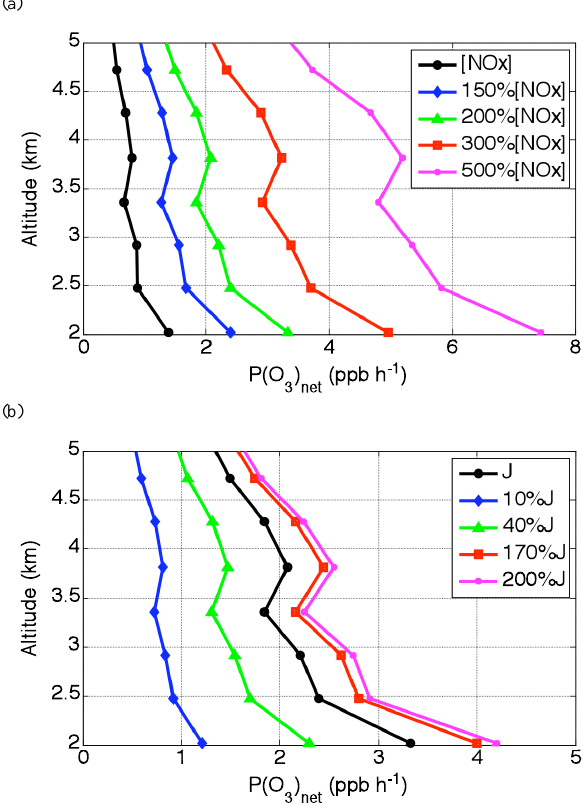
Figure 12. Calculated ozone net production P net (O 3 ) within the altitude of 2 – 5 km based on 5 Fig. 12. Calculated ozone net production P net (O 3 ) within the al- the modeling results from the aircraft data at UTC 1645 – 1700 on 5 Aug 2007 with initial and 6 titude of 2–5km based on the modeling results from the aircraft controlled (a) NO x concentrations and (b) photolysis rates (J values) with 200%[NO x ] case. 7 data at UTC 16:45–17:00 on 5 August 2007 with initial and con- trolled (a) NO x concentrations and (b) photolysis rates ( J values) with 200%[NO x ]